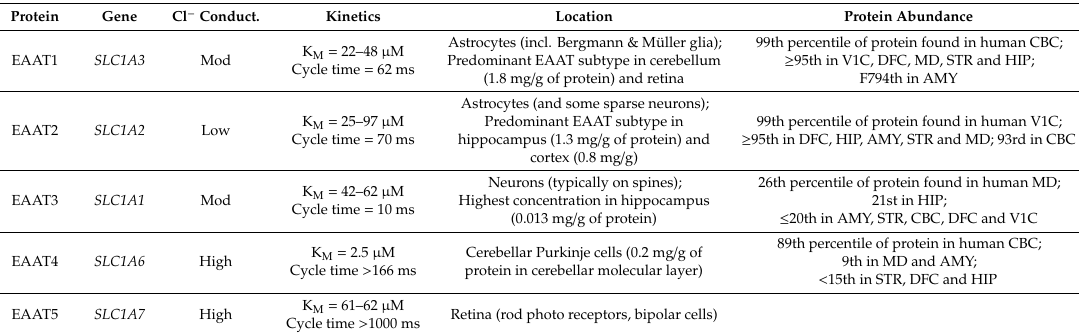
Table 1. Excitatory amino acid transporter family